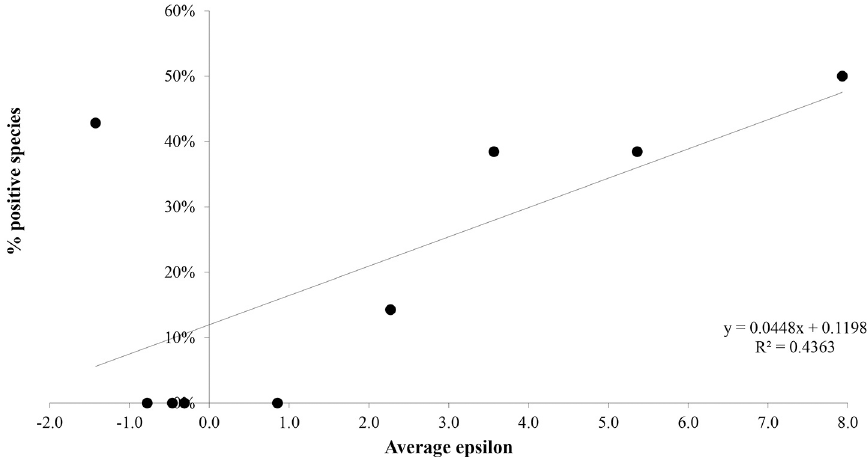
Fig 2. Percentage of species identified as positive for presence of L . ( L .) mexicana in relation to mean epsilon